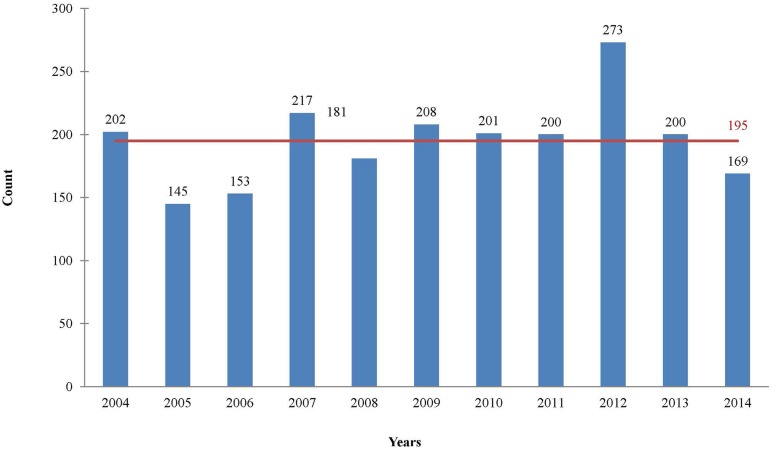
Distribution of retrieved hearts between 2004 and 2014.